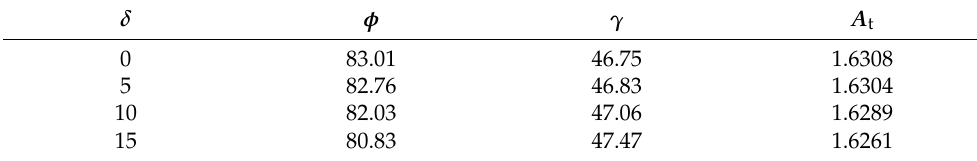
Table 3. Optimal angles and areas for a tapered mattress with taper angles.